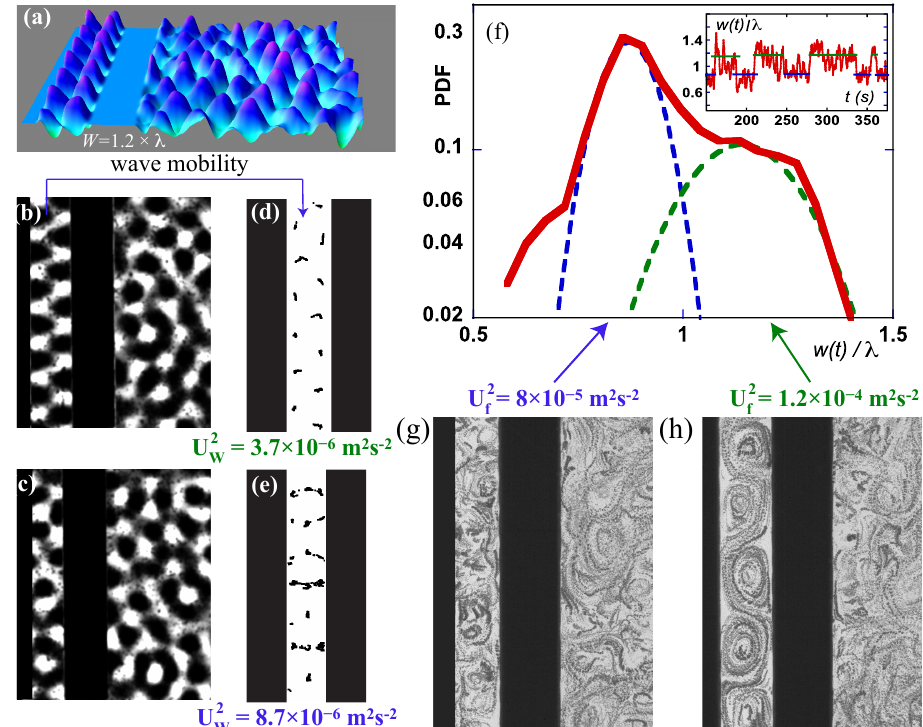
Figure 5. ( a ) 3D instantaneous visualisation of a resonant wave field for a beam spacing W = 1.2 × λ . ( b , c ) diffusing light images of the resonant wave mode and disordered waves in the high-confinement regime; ( d , e ) trajectories of the wave peaks measured inside the cavity for the resonant waves and the chaotic waves at fixed vertical acceleration a = 1 g; ( f ) PDF of the instantaneous gap w ( t ) when the mean separation is W ∼ λ . The PDF can be modelled by two Gaussian distributions centred on w 1 and w 2 with different variances. Inset: Dynamics of the time-varying gap w ( t ) . ( g , h ) Fluid particle streaks show the wave-driven flows in disordered waves and during a wave resonance at